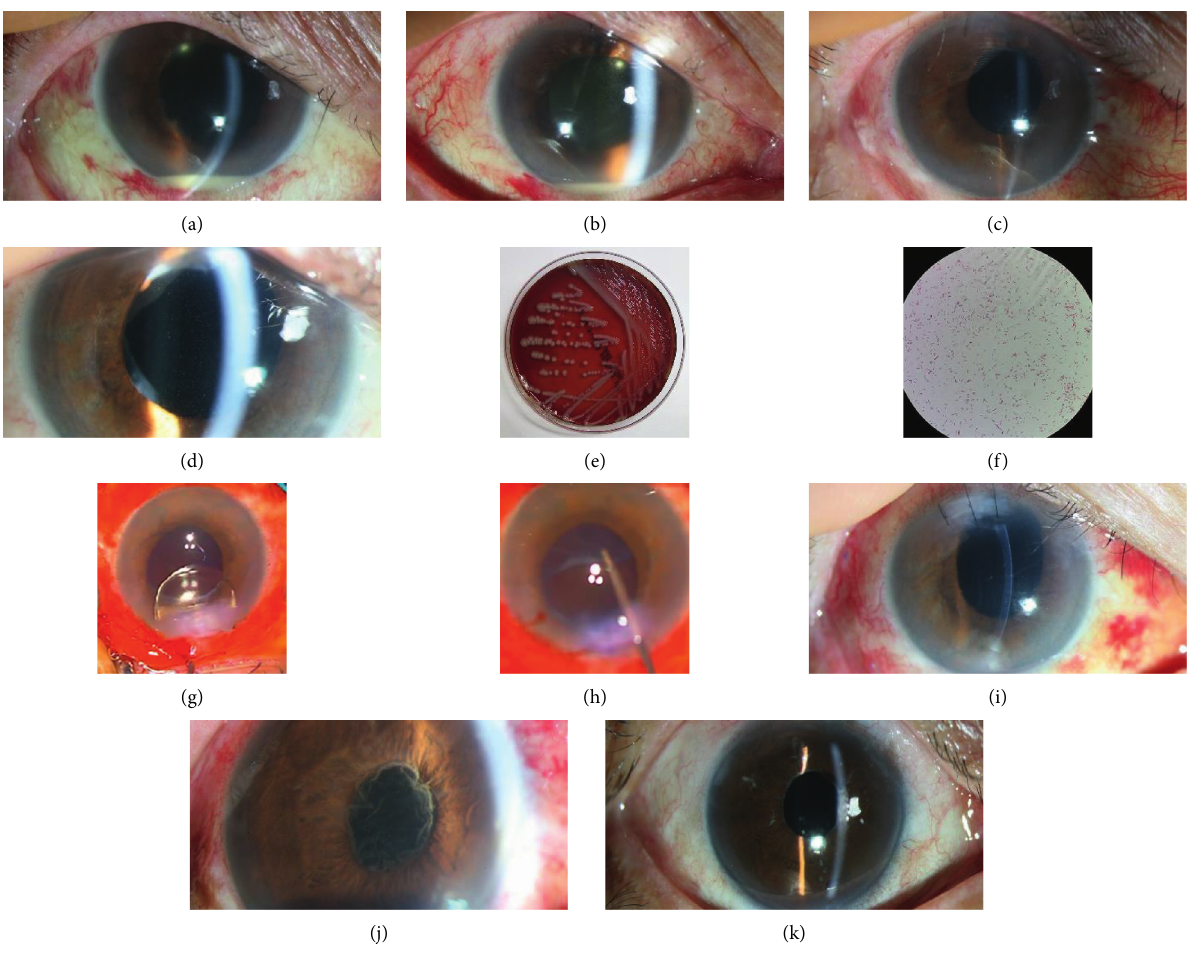
Figure 1: Representative cases of endophthalmitis caused by Achromobacter xylosoxidans . (a) The corneal edema, anterior chamber cell reaction, hypopyon, and pupillary membrane were found at the first visit. (b) In spite of pars plana vitrectomy and intravitreal injection, the endophthalmitis has aggravated. (c) Intraocular lens was removed and partial lens capsule was removed by the outcome and quiet state persisted. (d) After ciliary sulcus fixation of the intraocular lens, cellular reactions have recurred. (e) The Gram-negative rod Achromobacter xylosoxidans was revealed from blood agar plate culture. (f) Microphotograph of Achromobacter xylosoxidans with gram staining ( × 1000). (g) Surgical procedure showing removal of the intraocular lens. (h) The remnant lens capsule is being removed completely using microforceps. (i) After additional vitrectomy, repeated intraocular lens removal, and en bloc delivery of the lens capsule, recurrence has stopped thereafter. (j) Another patient showed the anterior chamber reaction and severe pupillary fibrotic membrane from the initial presentation. (k) Completely healed state after repeated intravitreal injections and vitrectomies, including en bloc delivery of the lens